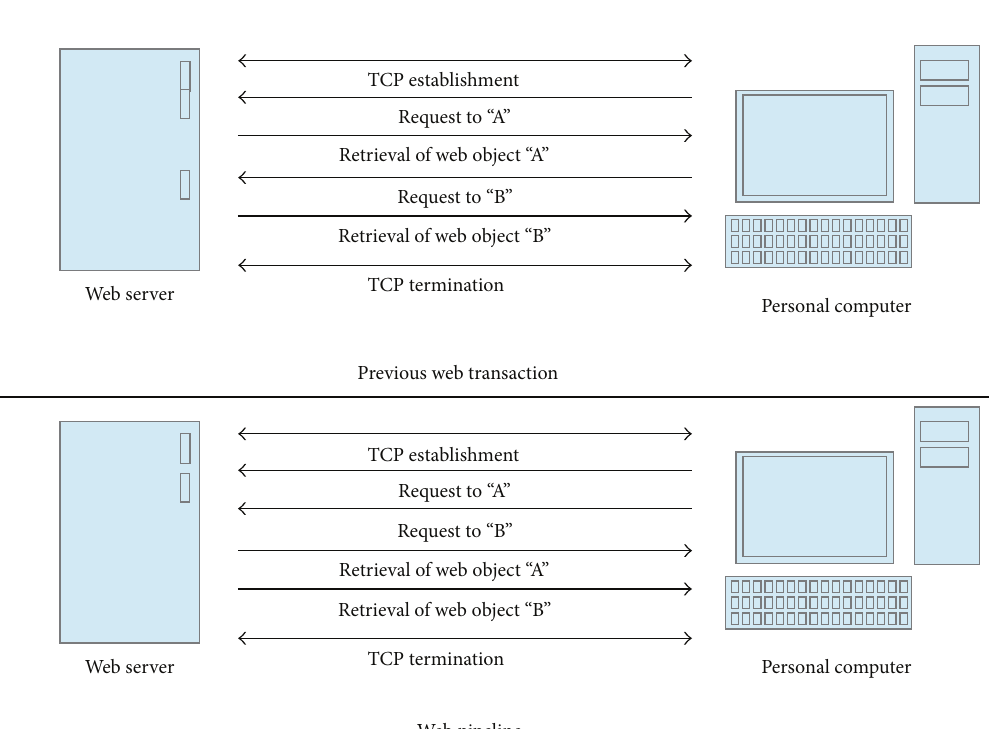
Figure 3: Retrieval of web document by the multiple